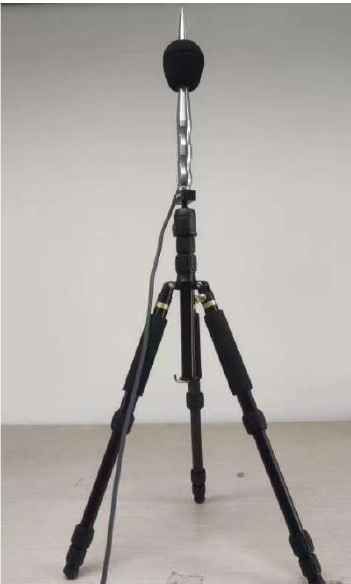
Figure 6. Front-end acoustic acquisition